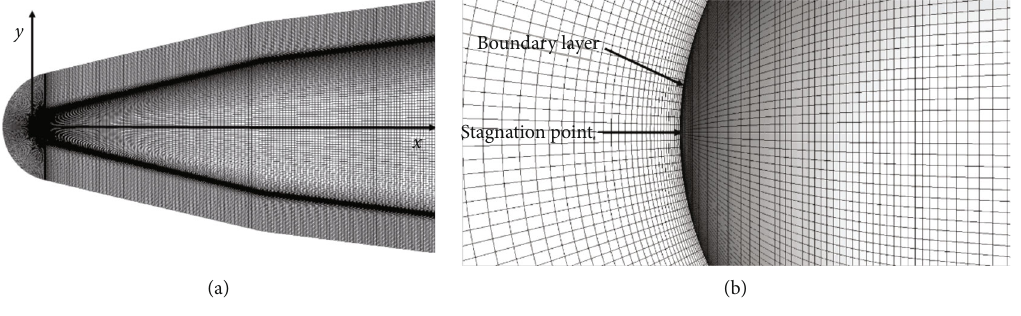
Figure 3: Computational domain and grid. Table 2: Grid parameters with di ff erent